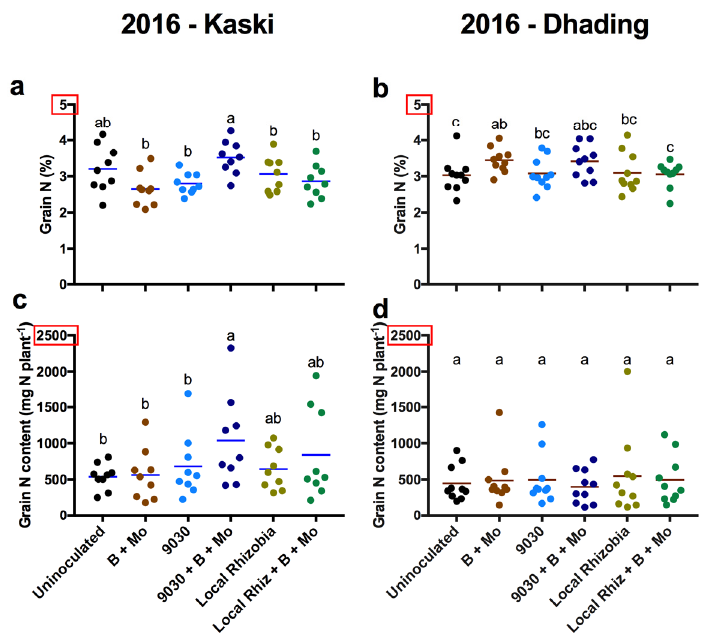
Figure 3. Grain N data collected at the Dhading and Kaski sites in 2016. ( a , b ) Grain N% at ( a ) Kaski-2016 and ( b ) Dhading-2016. ( c , d ) Grain total N content at ( c ) Kaski-2016, and ( d ) Dhading-2016. Each dot represents an individual farm, while horizontal solid lines represent the mean value of each treatment. Dots followed by the same letter grouping are not significantly different at p < 0.05. n = 10 (except n = 9 at Kaski-2016). Please note that the y-axis scales vary, as indicated by the red boxes.